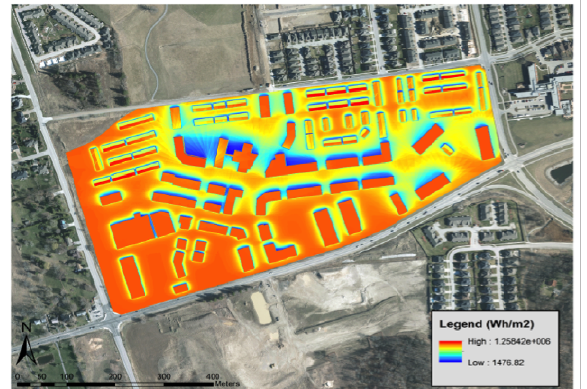
Figure 5. Example of an annual solar insolation map generated from the methodology for the original site